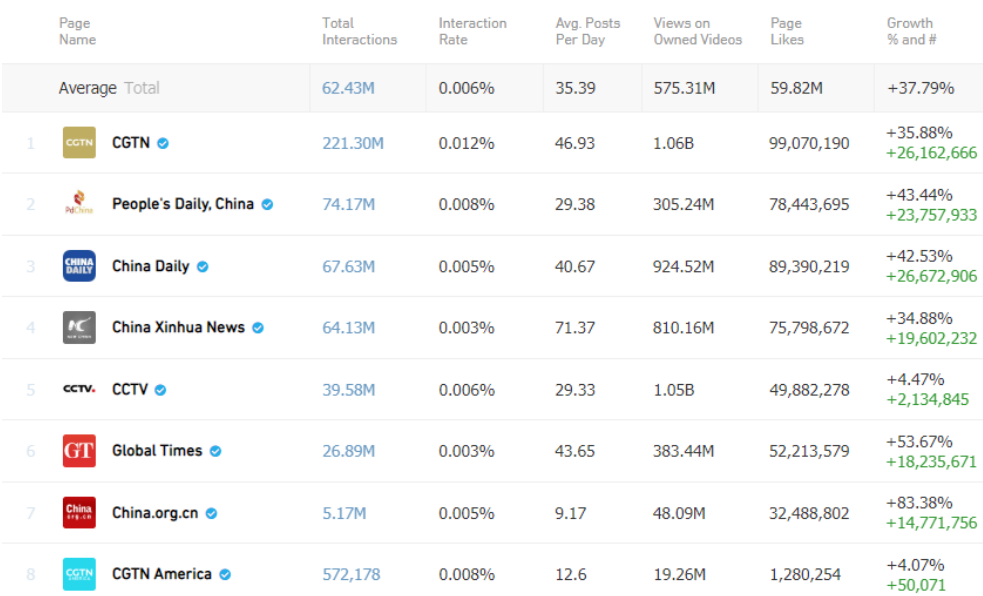
Table A : List of Chinese state media Facebook pages analyzed using the tool CrowdTangle from Jan 1, 2019 to March 31, 2020, showing rapid audience growth, a significant audience size, and